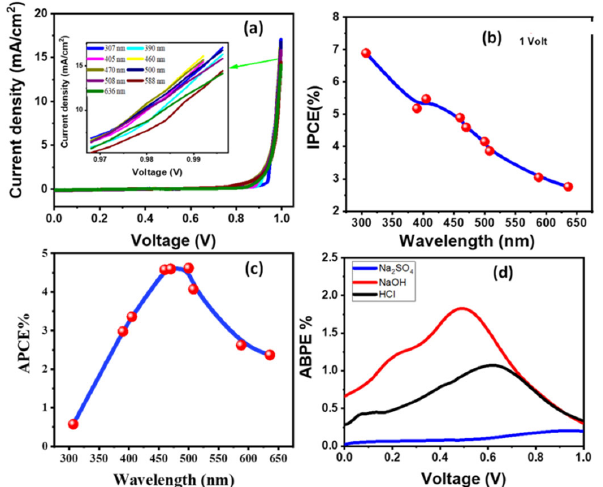
Figure 8. ( a ) J ph ‐ voltage characteristics of (2.5 % Co, 673 K) photoelectrode under monochromatic light illumination at RT in 0.5M NaOH, ( b ) IPCE% and ( c ) ABCE% ( λ ) @+1 V versus the incident wavelength, and ( d ) ABPE % versus the applied voltage for various electrolytes.